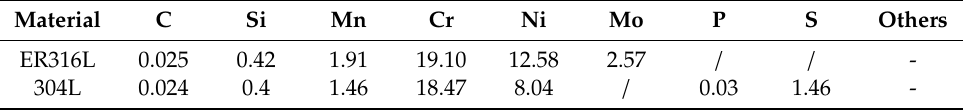
Table 1. The chemical composition of welding wire material and base material (mass fraction, %).